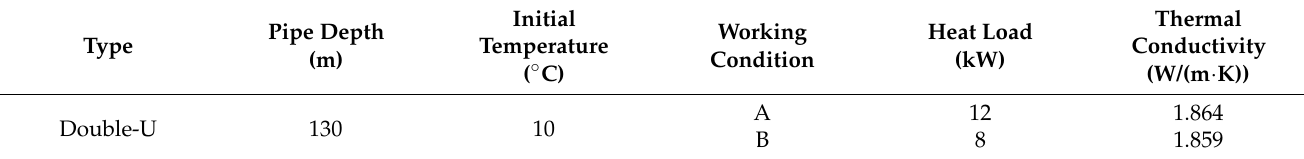
Table 5. TRT results.